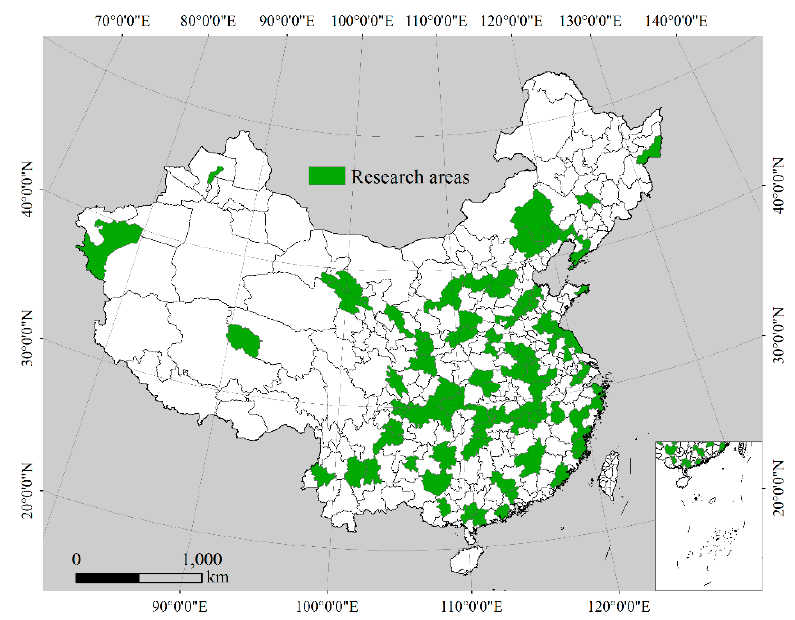
Figure 1. Distribution of study areas in China Health and Retirement Longitudinal Study.